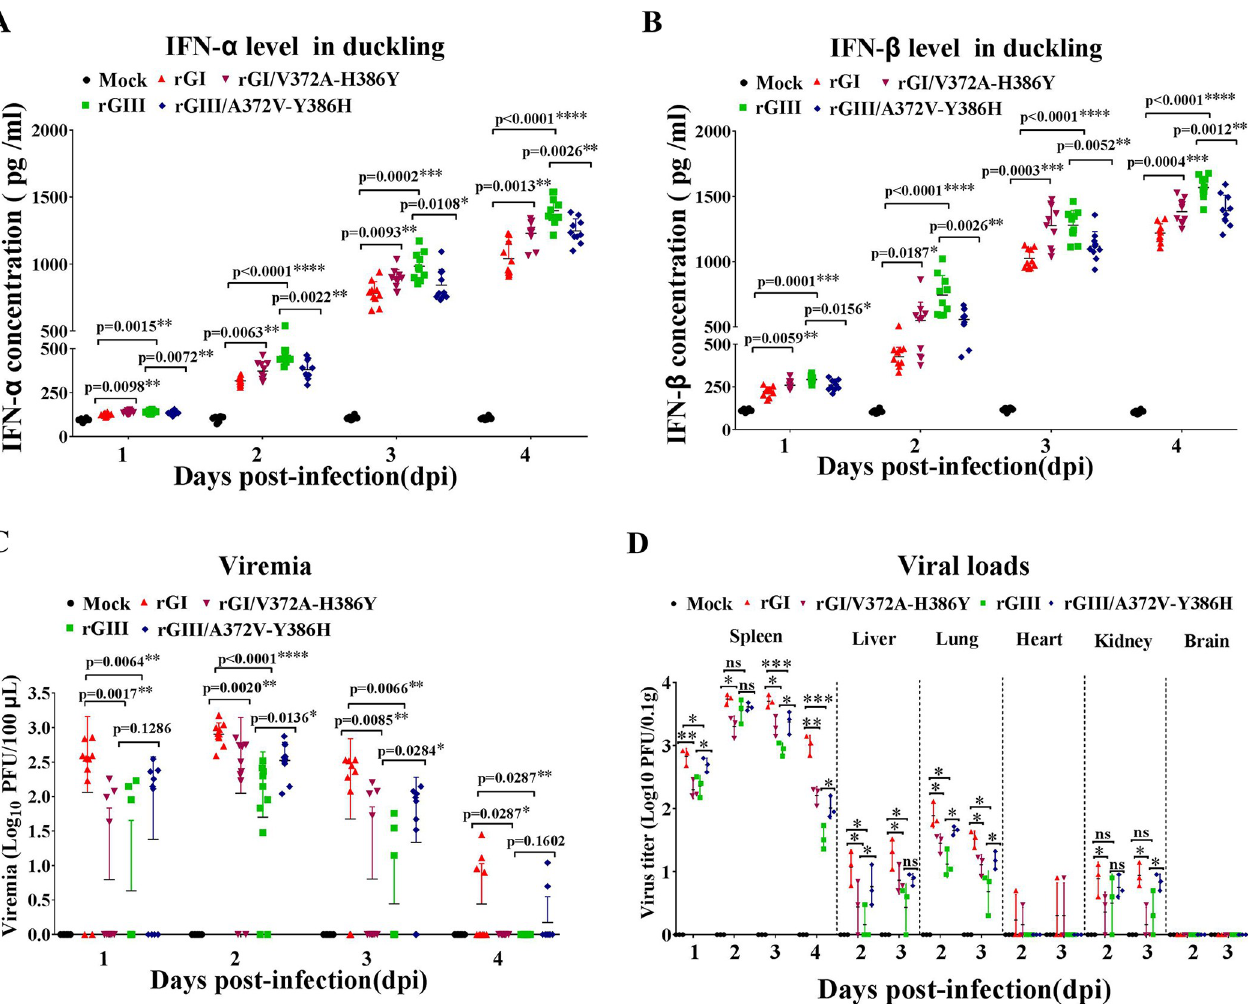
Fig 10. Effects of NS5-V372A and NS5-H386Y variations on IFN- α and β production and viremia in ducklings. (A, B and C) Two-day-old SPF domestic ducklings ( n = 10) were intramuscularly inoculated with the indicated substitution mutant viruses. Blood samples were collected daily through the jugular vein from 1 to 4 dpi for measurement of the levels of IFN- α (A) and IFN- β (B) production and viremia (C). (D) Detection of viral loads in tissues. Two-day-old SPF domestic ducklings ( n = 12) were intramuscularly inoculated with the indicated substitution mutant viruses. Three ducklings per group were euthanized daily from 1 to 4 dpi for collection of tissues (spleen, lung, kidney, liver, heart, and brain). Viral loads in each tissue were titrated with TCID 50 assays on BHK cells. Data are shown as means ± SD. ��� , p < 0.001; �� , p < 0.01; � , p < 0.05; ns, no significance, by Student’s t